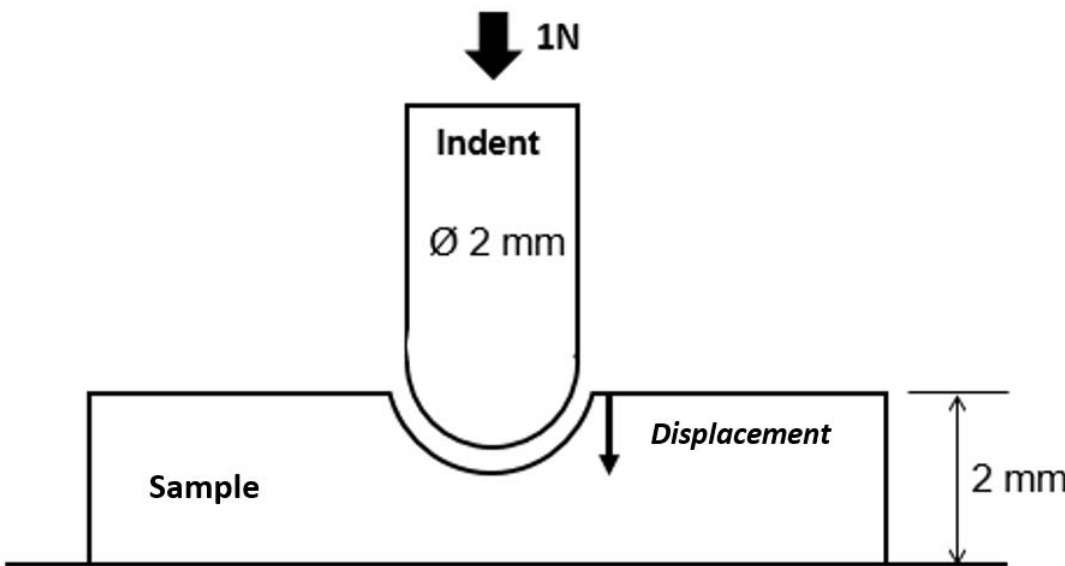
Figure 4. Penetration tests